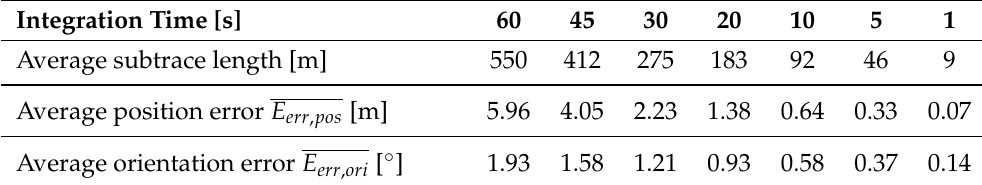
Table 5. Average pose errors with different integration